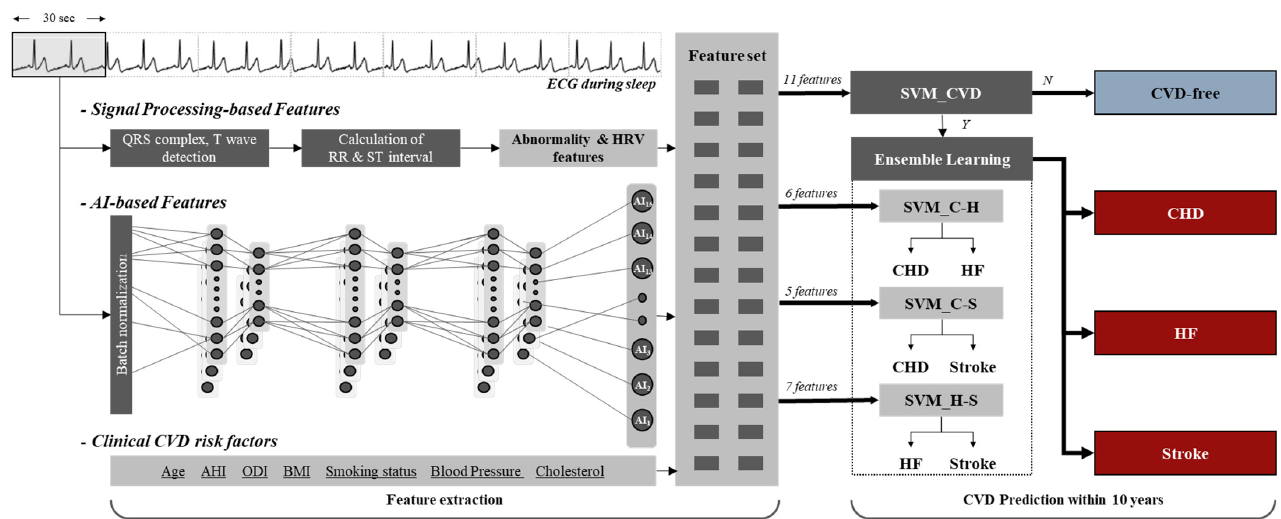
Figure 3. Prediction model of incident CVD outcomes in patients with SDB. SP = signal processing; AI = artificial intelligence; ECG = electrocardiogram; CVD = cardiovascular disease; SDB = sleep-disordered breathing; SVM = support vector machine; C = coronary heart disease; H = heart failure; S = stroke; * is used to distinguish the feature extraction methods.